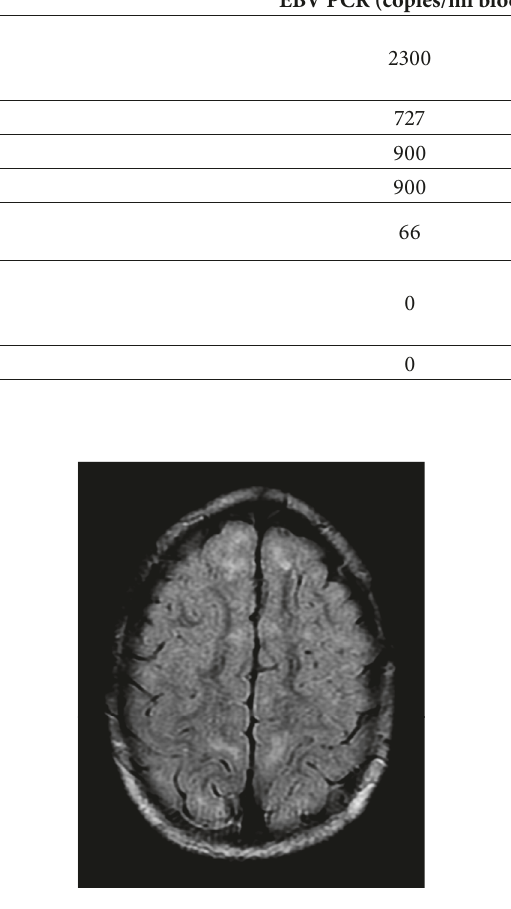
Figure 1: Axial T2-FLAIR MRI image demonstrating subcortical white matter hyperintensities most prominent within the frontal lobes. Image is courtesy of Dr. Jane